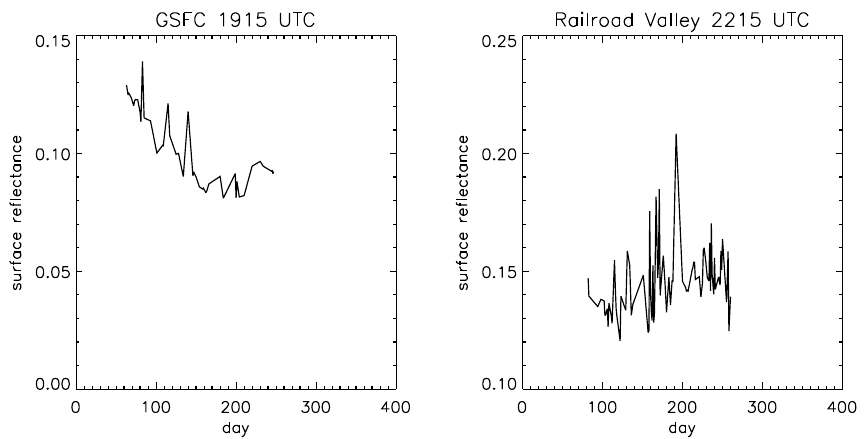
Fig. 10. Surface reflectance timeseries at GSFC (19:15UTC) and Railroad Valley (22:15UTC). The surface reflectance is retrieved using GOES channel 1 TOA reflectance and AERONET AOD in 20 × 20km 2 areas at the AERONET sites.